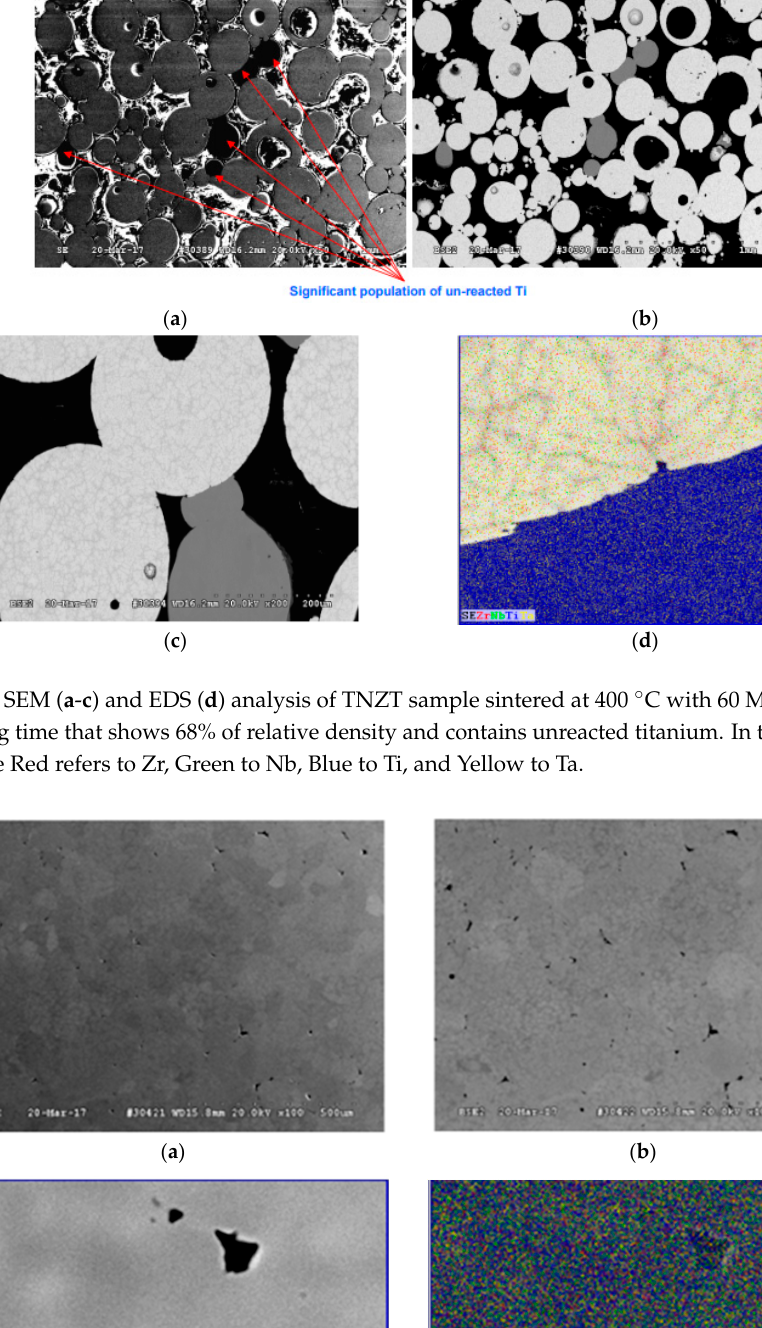
( i ) Figure 6. ( a – e ) EBSD inverse pole figure maps for five different samples and pole diagrams for ( f ) Tantalum; ( g ) Zirconium; ( h ) Titanium and ( i ) Niobium.